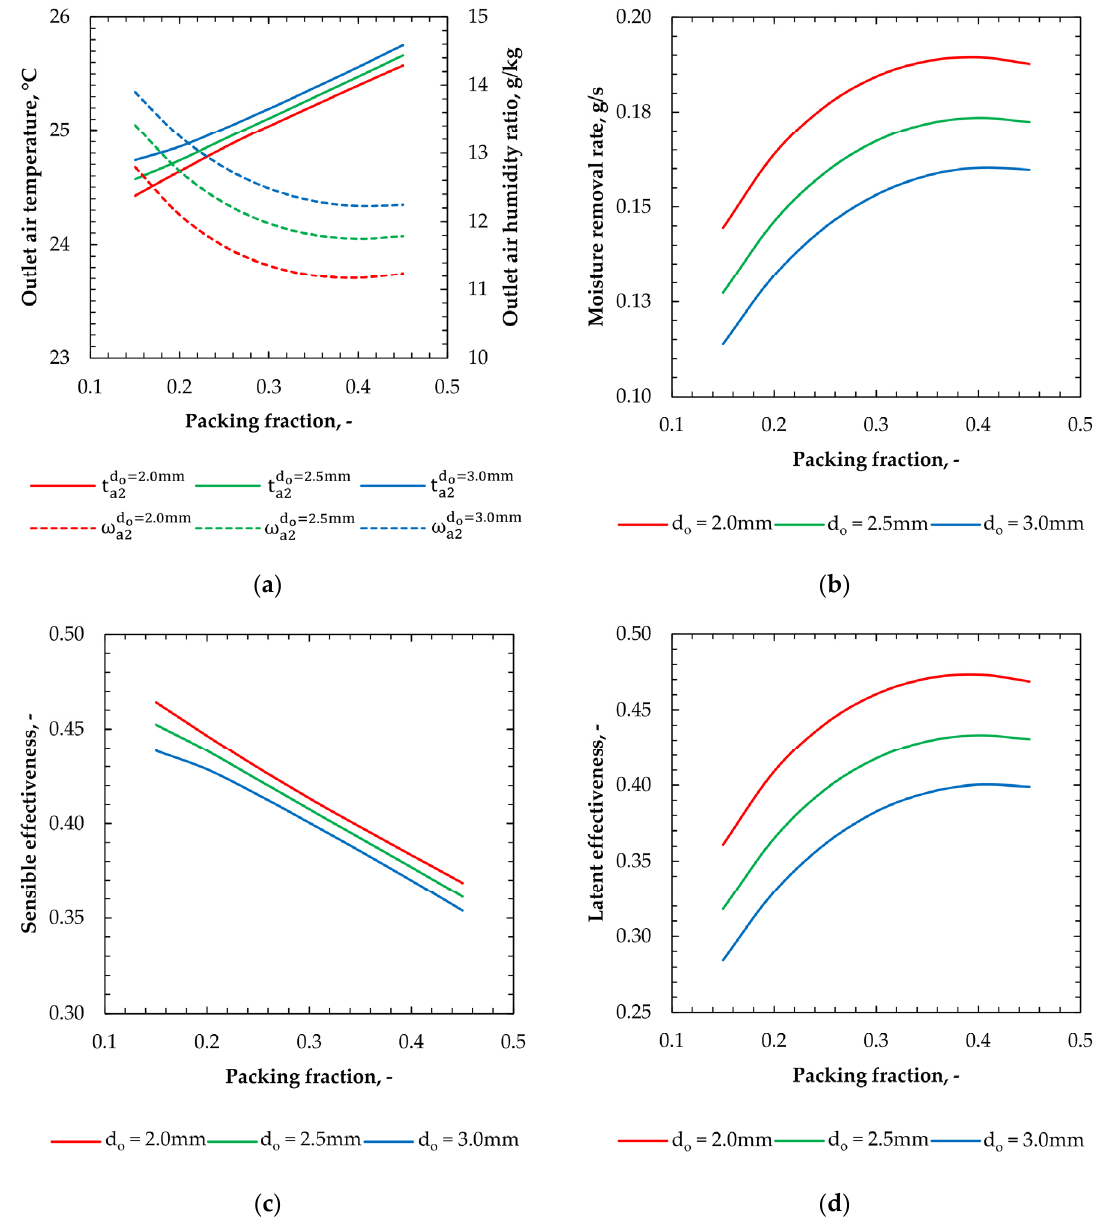
Figure 10. Effect of module packing fraction in regard to different hollow fiber membrane outer diameters: ( a ) on outlet air temperature and outlet air-humidity ratio; ( b ) on moisture removal rate; ( c ) on sensible effectiveness; ( d ) on latent effectiveness.